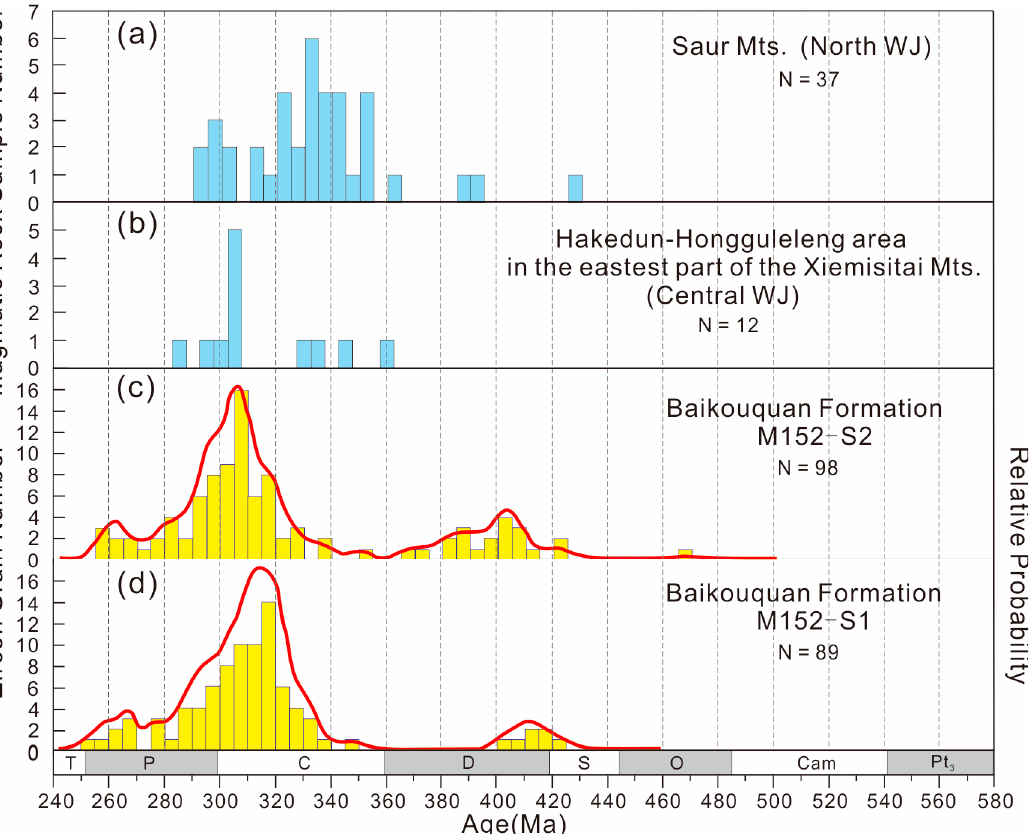
Figure 9. Magmatic rocks age distribution from ( a ) Saur arc of North WJ, ( b ) Hakedun-Hongguleleng regions of Central WJ, ( c , d ) Frequency and relative probability density curves for zircons U-Pb ages from the Xiazijie fan-delta.